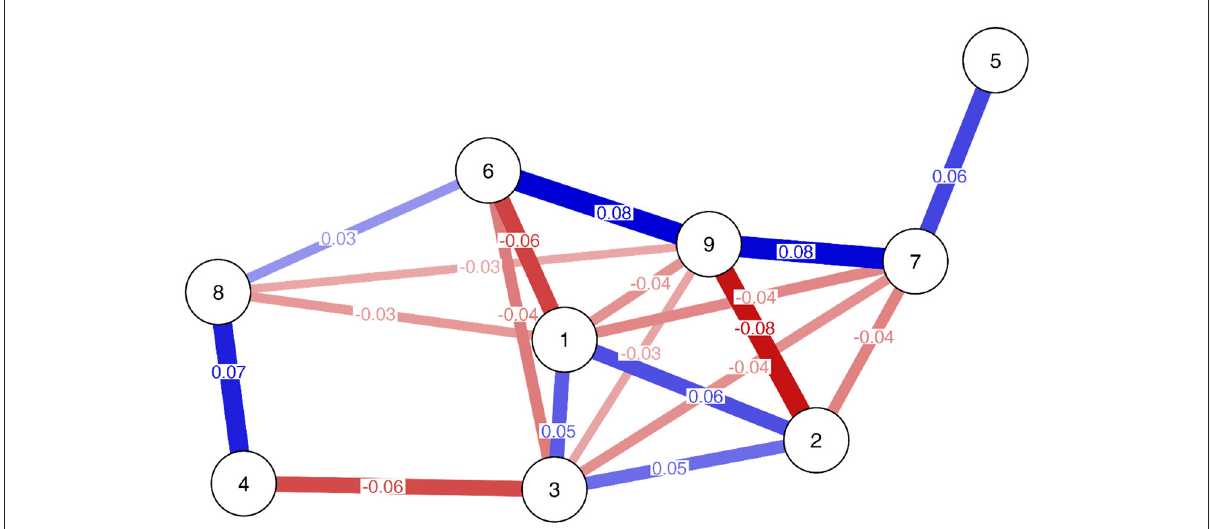
FIGURE1 Residual network model of the Social Media Disorder Scale. Node labels indicate items: 1 = Preoccupation, 2 = Tolerance, 3 = Withdrawal, 4 = Persistence, 5 = Displacement, 6 = Problem, 7 = Deception, 8 = Escape, and 9 = Conflict. Red lines indicate negative edges, blue lines indicate positive edges. Color shades indicate edge weights (stronger edges are darker, weaker edges are lighter).